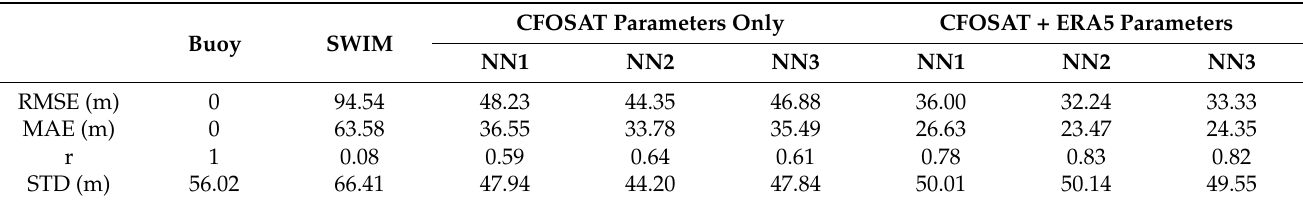
Table 3. Median RMSE, MAE, r, and STD of the dominant wavelength from the SWIM and NN models based on different input parameters.